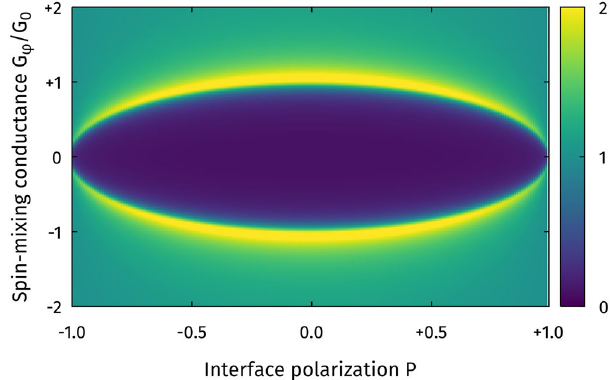
Figure 1. Plot of the zero-energy DOS D (0) as function of interface polarization P and spin-mixing conductance G ϕ . The DOS was calculated in the center of the normal metal in an S/FI/N structure, where we used the BCS solution for the superconductor, treated the ferromagnetic insulator as a spin-active interface, and the normal metal was taken to have the length ξ S